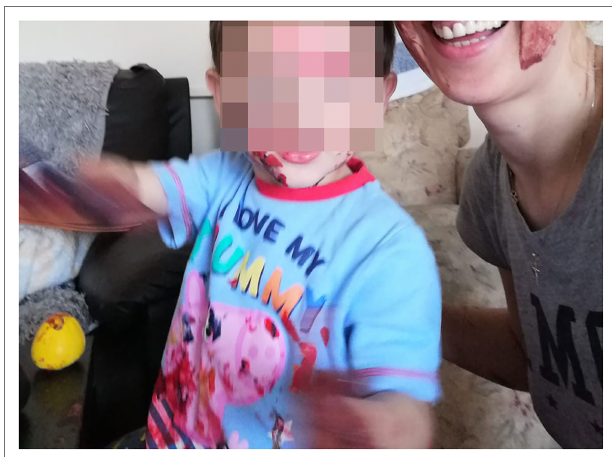
FIGURE 8 | Image shared of parent and infant doing activity together (image cropped and pixelated).